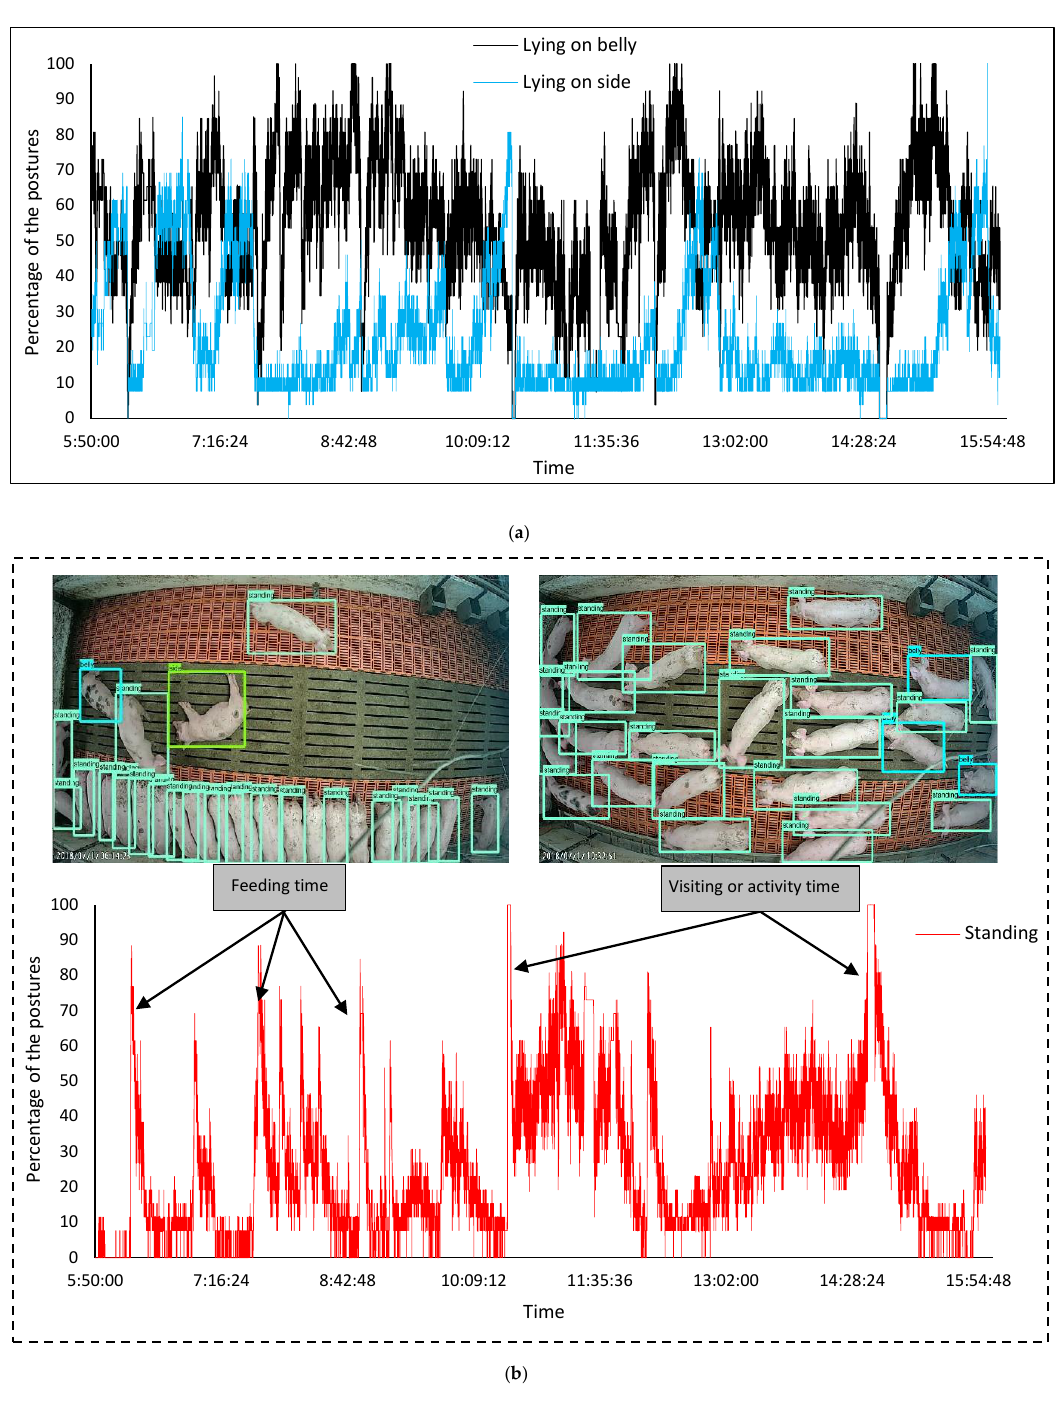
Figure 9. ( a ) Results of scoring (in percentage) of the lying and standing postures across the day. ( b ) Standing posture (light blue rectangle), lying on belly (blue rectangle) and side posture (green rectangle).